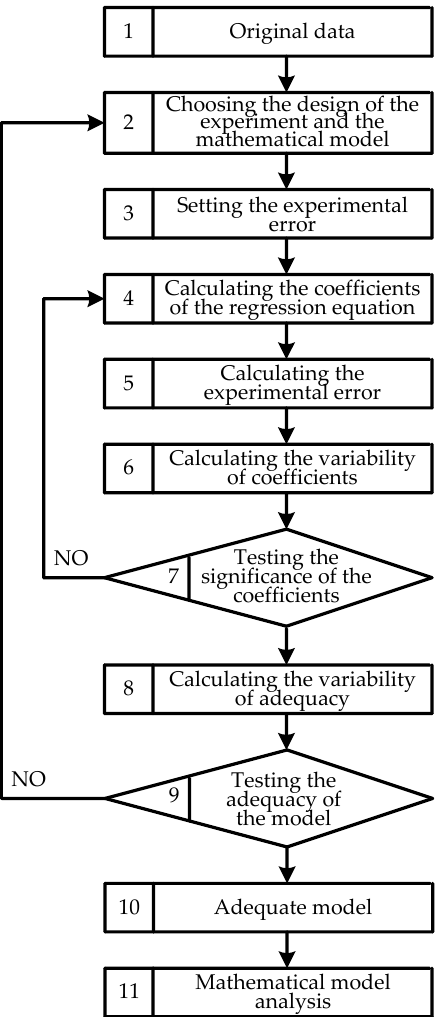
Figure 2. Algorithm of conducting the research by method of active design of the